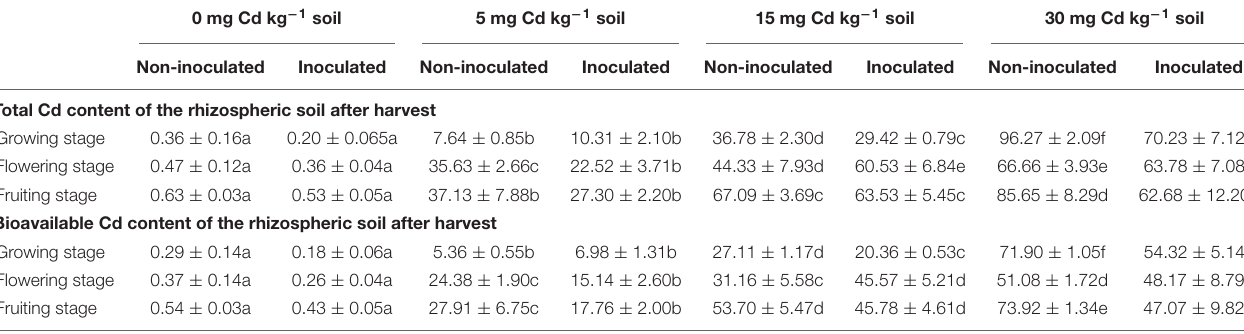
TABLE 2 | Effects of endophyte FZT214 on total and bioavailable Cd in the soils at different developmental stages.